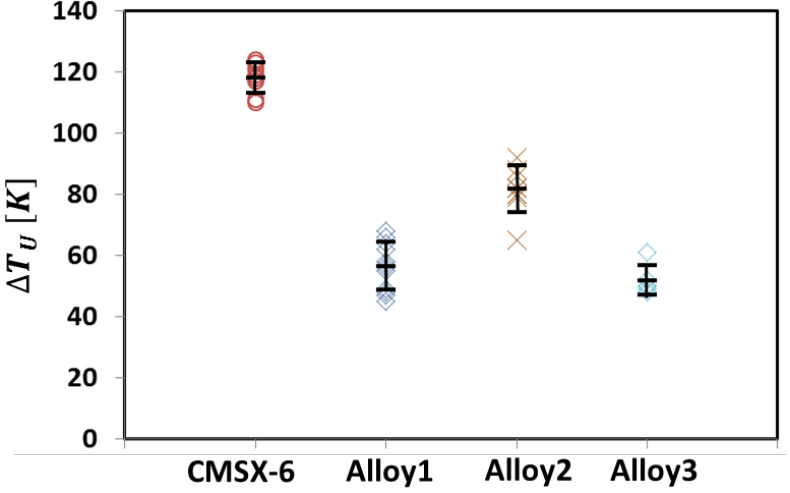
Figure 10. Critical undercooling Δ T U of Alloy1, Alloy2 and